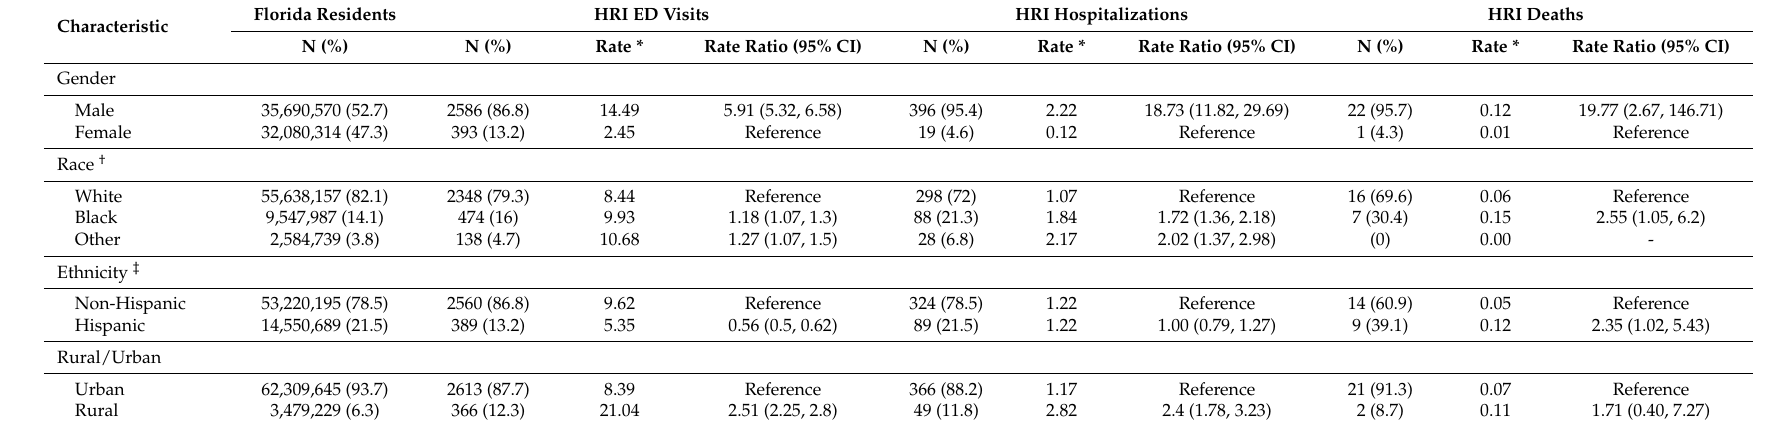
Table 3. Distribution of work-related HRI among Florida resident by selected characteristics